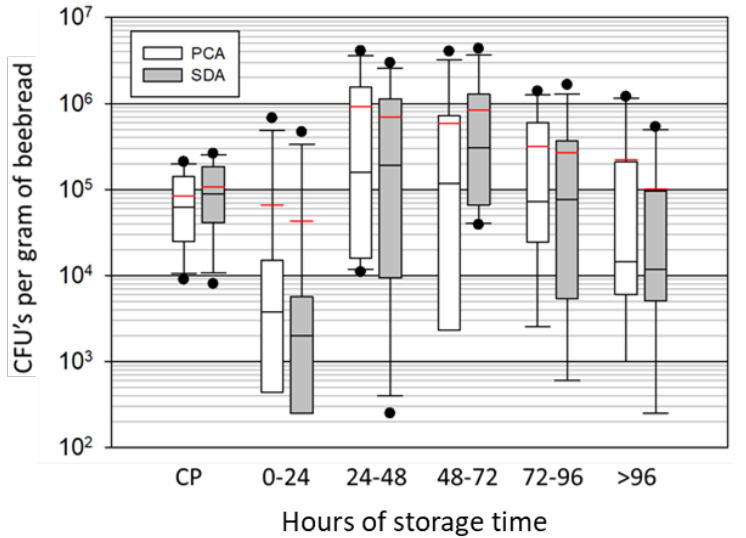
Figure 2. Total microbial growth in August (primarily yeast and bacteria) from fresh corbicular pollen (CP) and beebread sampled daily for 5 days at 24 h increments. Identical samples were plated in triplicate on standard plate count agar (PCA) and Sabouraud dextrose agar (SDA). Each box plot displays the sampled variation from eight colonies. The red line is the mean, black the median, boxes are at 25% and 75%, whiskers at 5% and 95%, and dots are outliers. Abundance differs significantly by time (F 5,66 = 2.98, p <